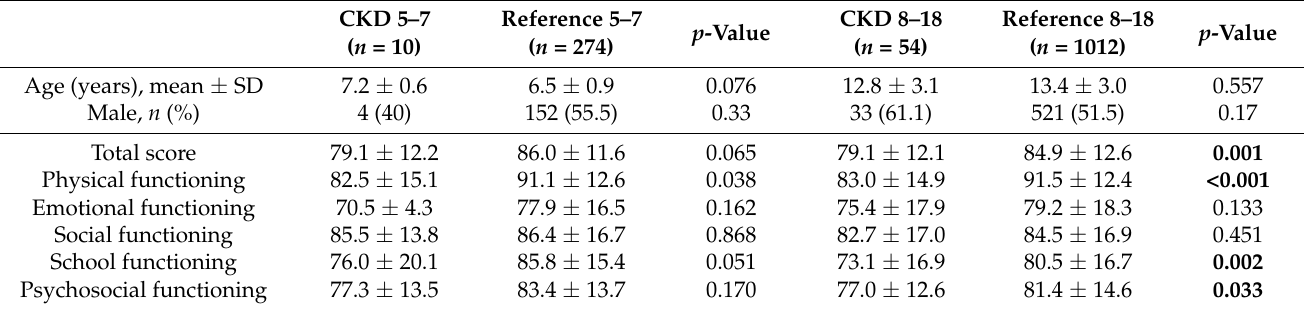
Table 3. Total scores and scores per subdomain of the PedsQL Generic 4.0. Scores (mean ± SD) are presented for CKD patients and the reference (general population) group aged 5–7 years (proxy- report) and aged 8–18 years (self-report). Psychosocial functioning consists of the emotional, social, and school functioning subdomains. Significant differences are shown in bold. CKD = chronic kidney disease; SD = standard